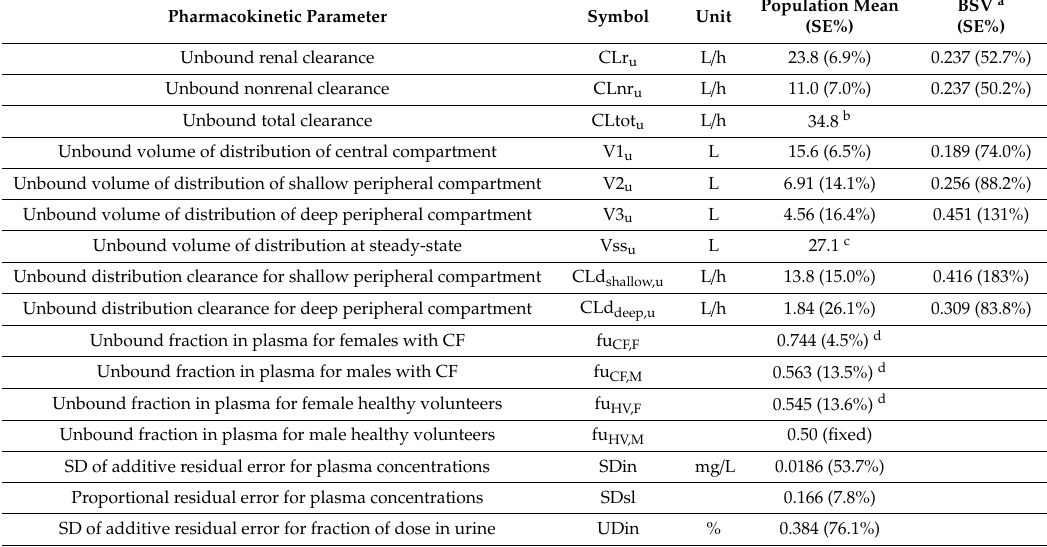
Table 4. Population pharmacokinetic parameter estimates for unbound cefotiam in patients with CF and healthy volunteers. All parameter estimates (except the additive residual errors) refer to unbound cefotiam. The model used allometric scaling with a standard LBM STD of 53